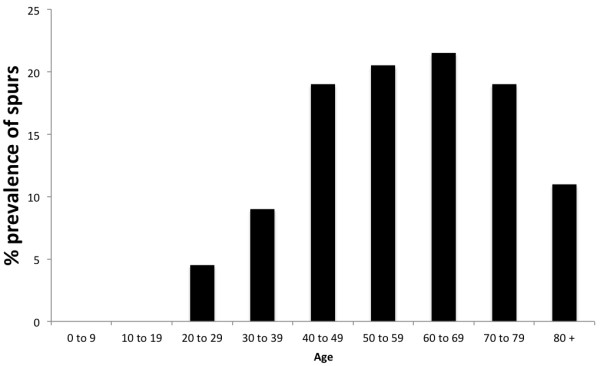
The prevalence of individuals with both an Achilles and plantar spur in different age cohorts. Note that the prevalence of individuals with both spurs increased up to 69 years of age and decreased thereafter.